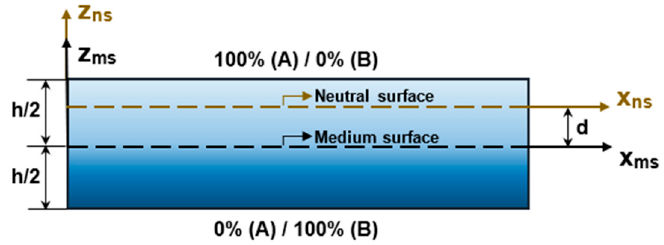
Figure 8. Medium and neutral surfaces.